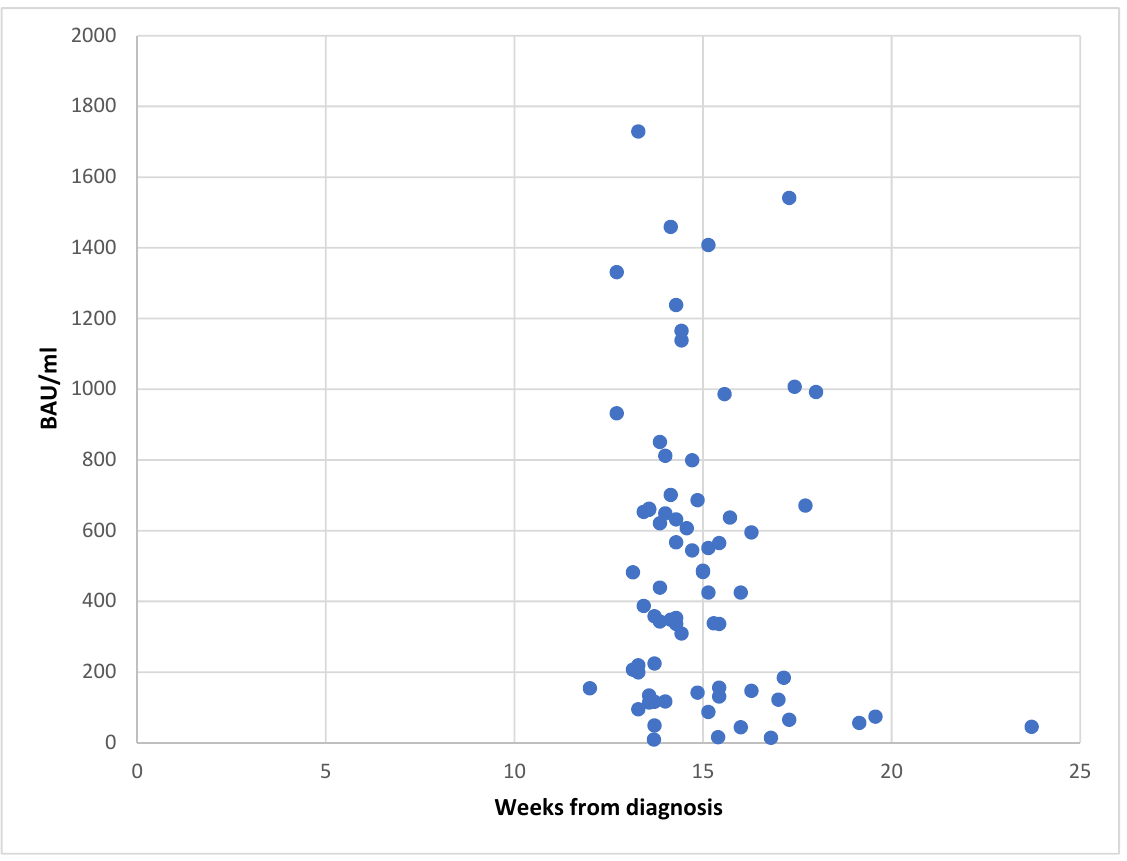
Figure 1. Distribution of the serum level of SARS-CoV-2 specific IgG antibodies by time from diagnosis in 73 children with COVID-19. At a median time of 3.5 months from the diagnosis, persistence of SARS-CoV-2 specific antibodies was observed in all but three tested patients, although with a widely variable range of titers. Table 1. Main clinical signs or symptoms of children admitted at the “Giovanni XXIII” Children Hospital of Bari between January 2020 and August 2021 and diagnosed with COVID-19.